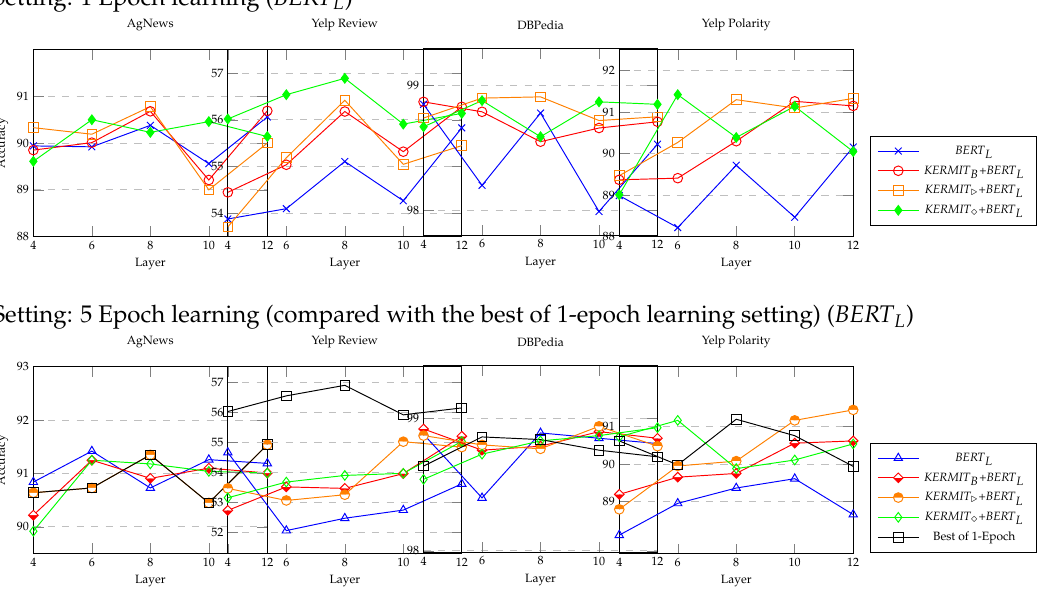
Figure 3. Comparison between KERMIT ./ Transformers and BERT when training layers in BERT L : Accuracy vs. Learned Layers in two different learning configurations—1-Epoch and 5-Epoch training